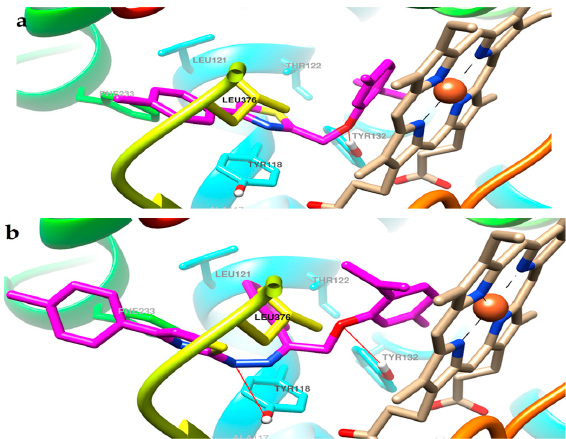
Figure 2. The top binding conformation of compounds 4e (subsection ( a )) and 7e (subsection ( b )). C atoms of the docked compounds to the active site of fungal lanosterol C14 α -demethylase are depicted in magenta. Unnecessary protein fragments in the background and foreground were removed for clarity.